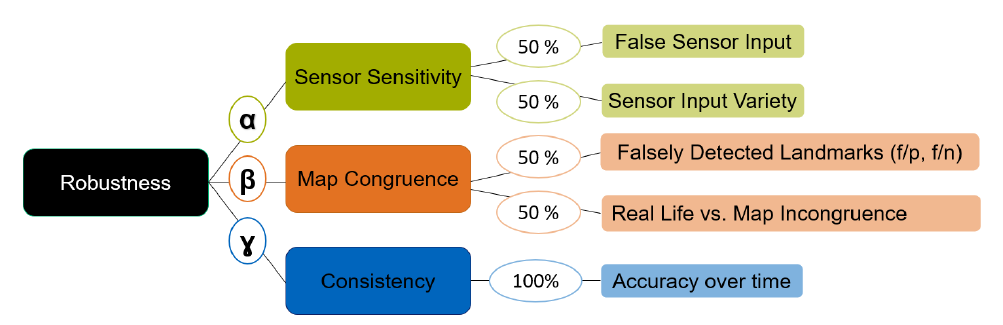
Figure 5. Composition of the robustness score. The metrics from Section 3.4 are combined to create a key indicator for